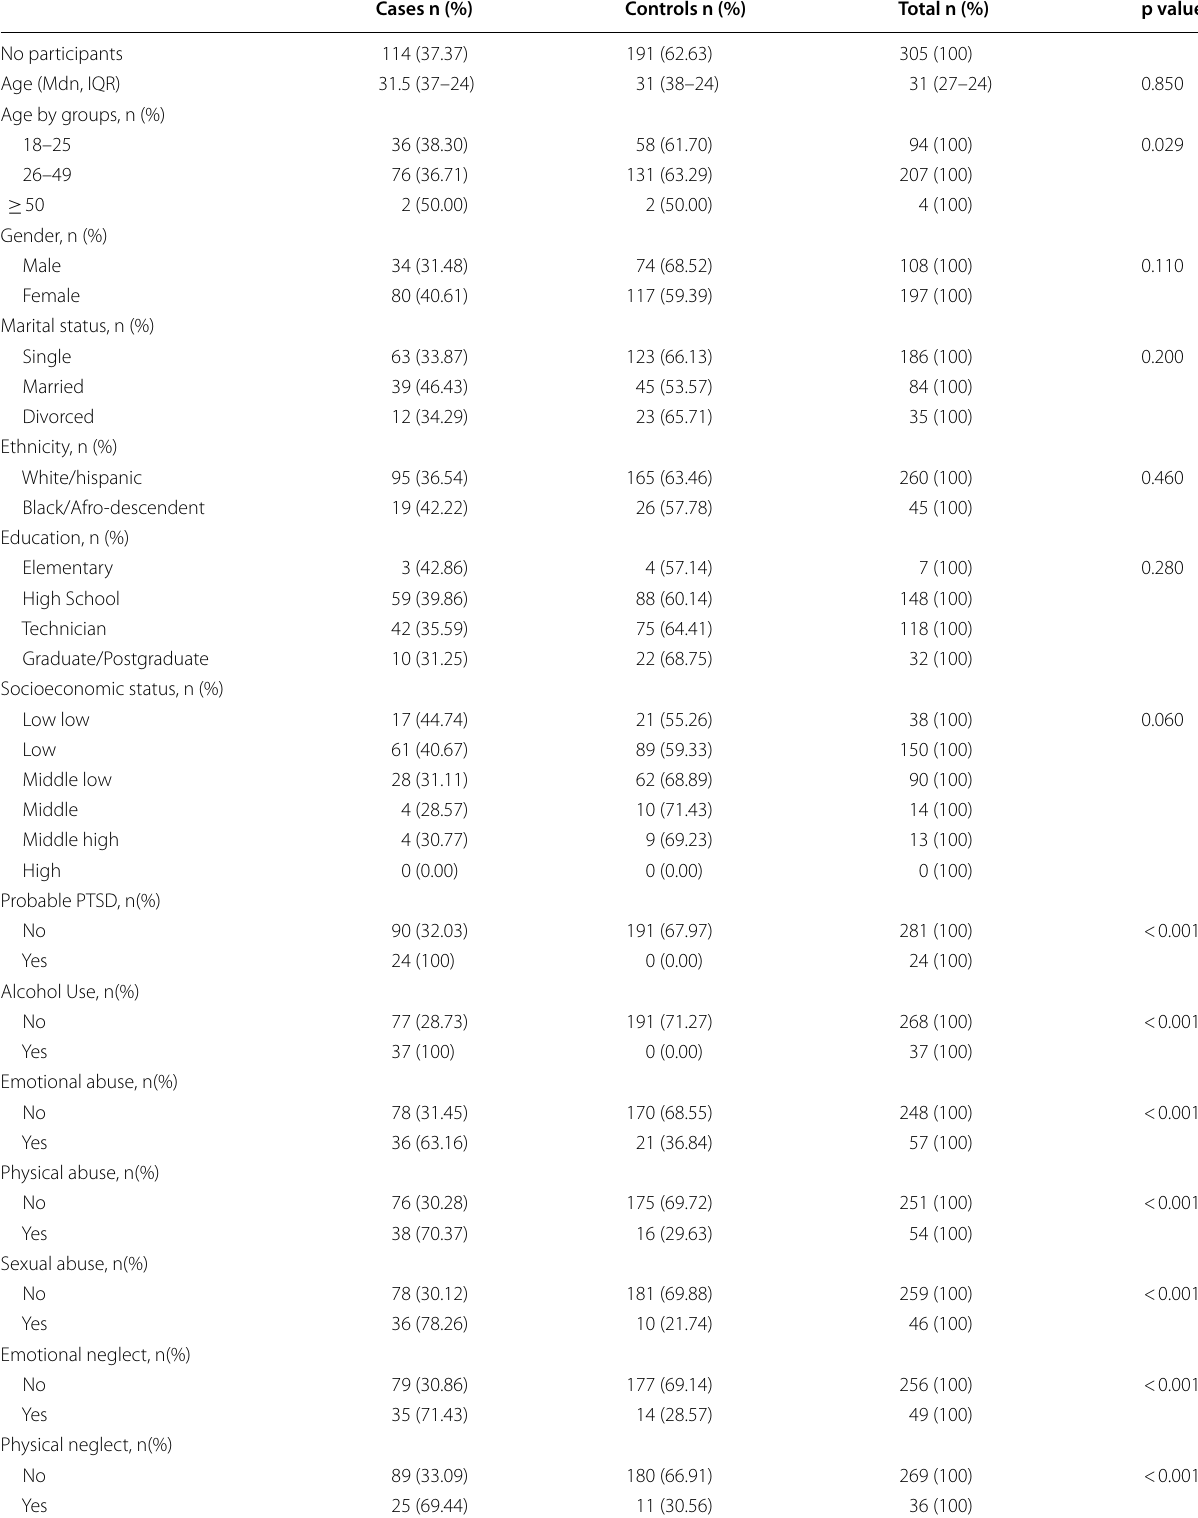
Table 1 Demographic characteristics of cases and controls (N